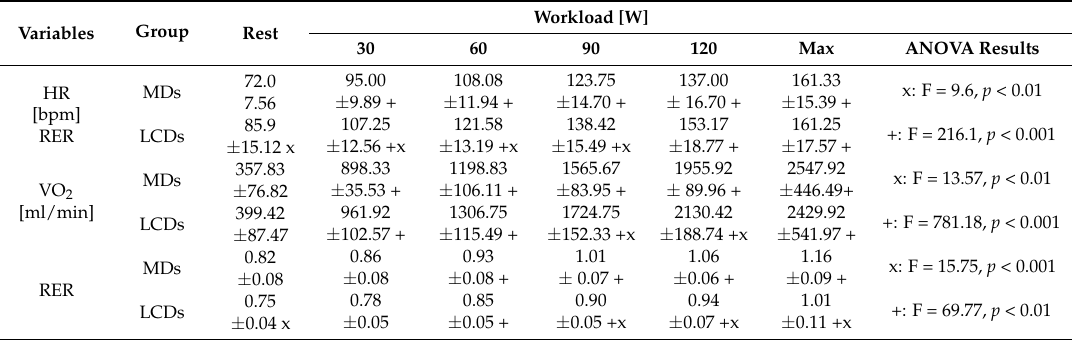
Table 6. Physiological participants’ variables connected with rest and exercise metabolism in the low carbohydrate diets (LCDs) and mixed diets (MDs) groups.